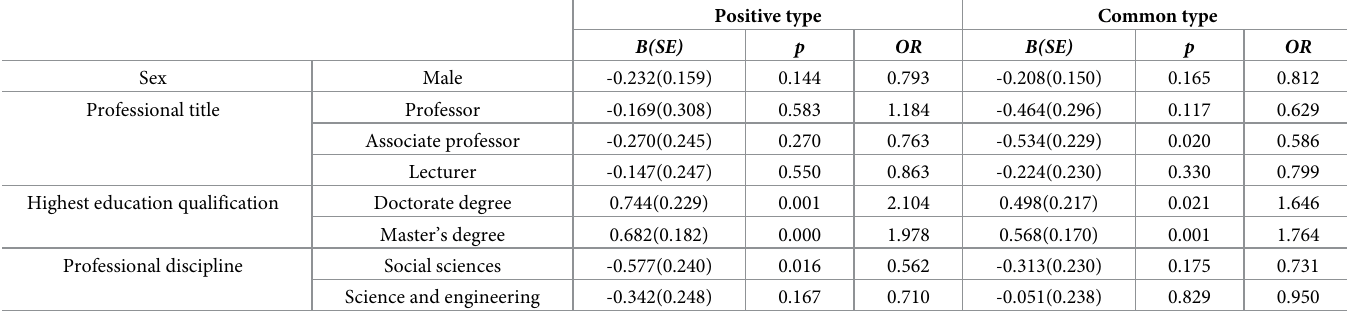
Table 3. Multiple logistic regression analysis of potential profile by college teachers’